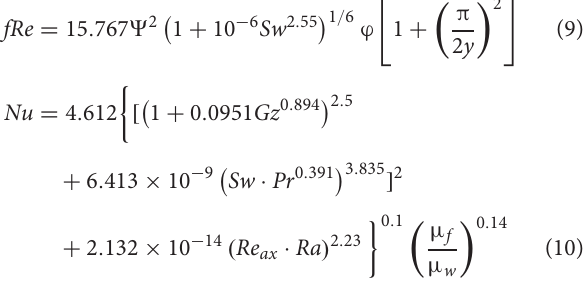
with higher Prandtl number fluids in the present range of the Reynolds number, which corresponds with previous analysis number ratio of oil in the tube with CCDTT and CCTTT